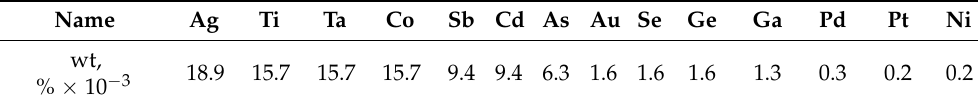
Table 3. Typical composition of valuable elements in PCB, based on available online references